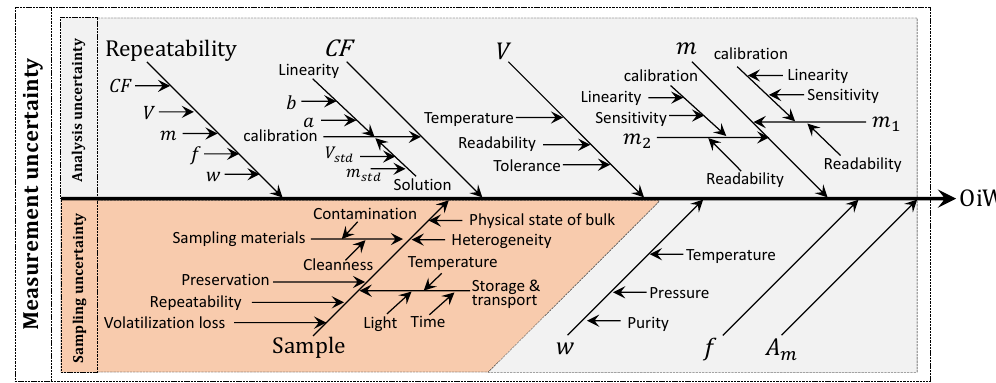
Figure 1. Cause-and-effect diagram of compounded uncertainties contribution to the measurement of OiW concentration by following the gas chromatography-flame ionization detector (GC-FID) reference method defined by OSPAR. The cause-and-effect diagram is divided into two sub-groups: Analysis uncertainty (gray) and sampling uncertainty